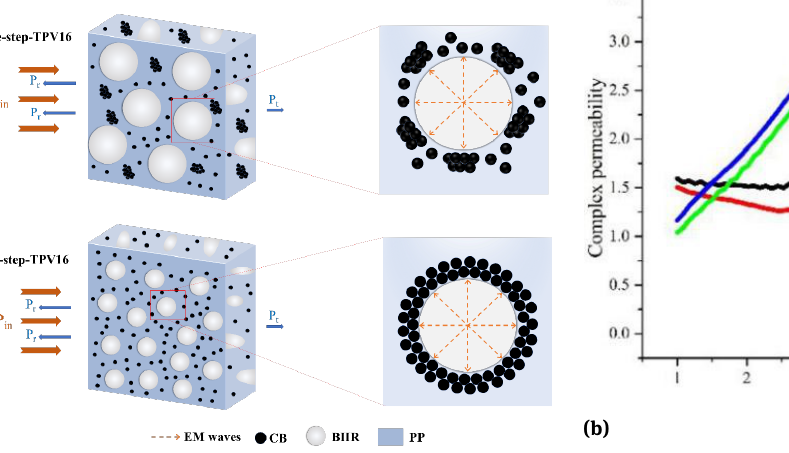
Figure 9: Schematic showing shielding mechanism of one-step- TPV16 and Two-step-TPV16.